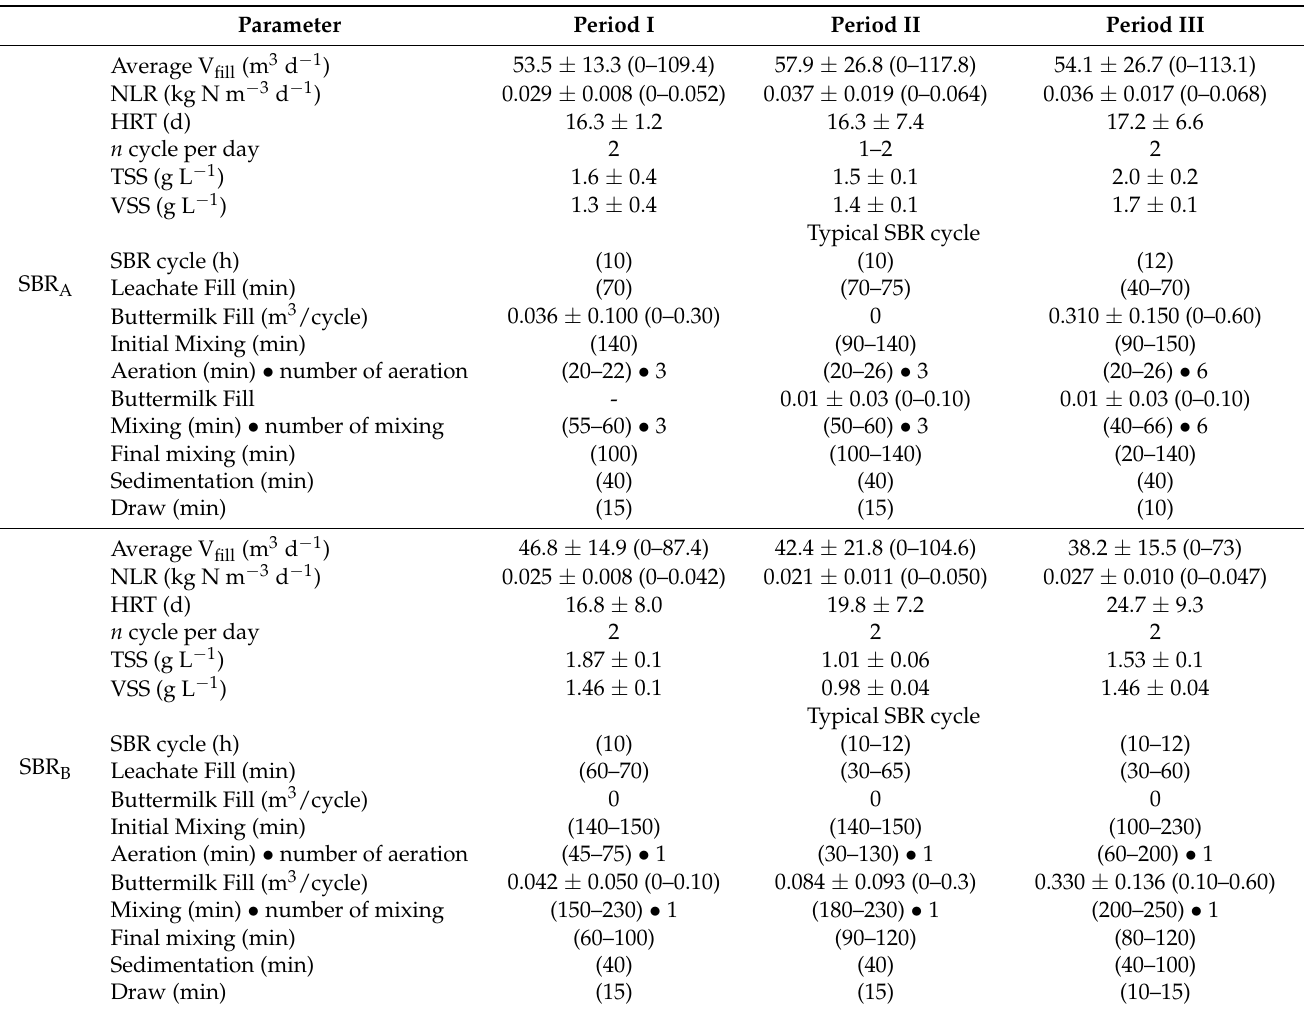
Table 1. Operating characteristics of